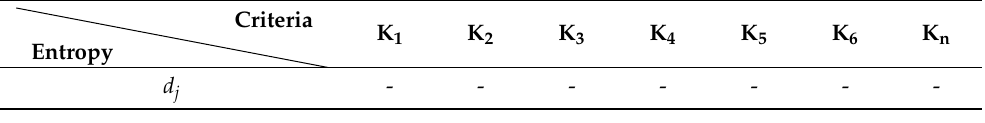
Table 9. The level of change of the criteria d j . Entropy